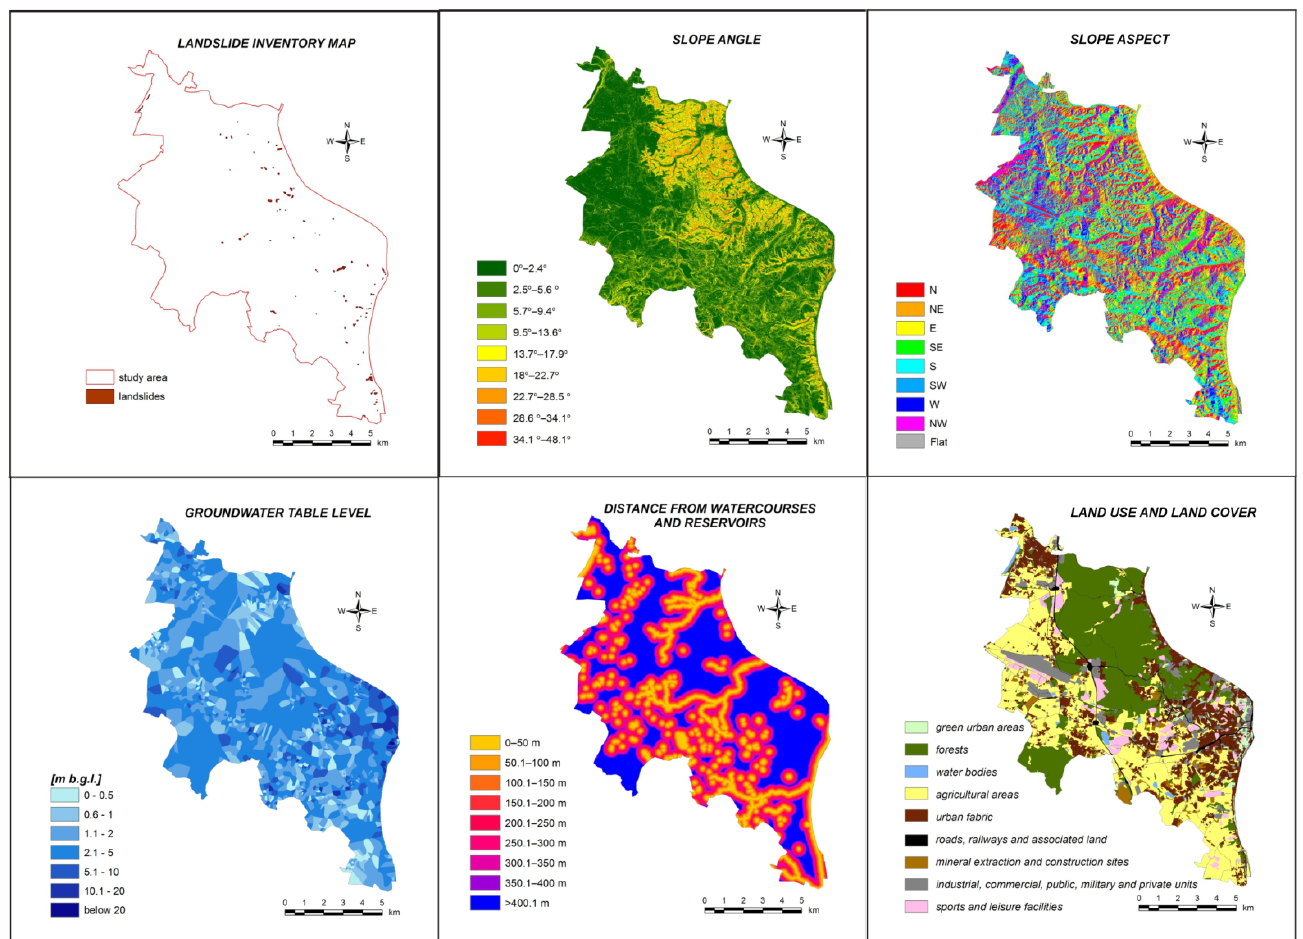
Figure 4. Selected thematic layers used in the GIS analysis in the Gda ń sk area.